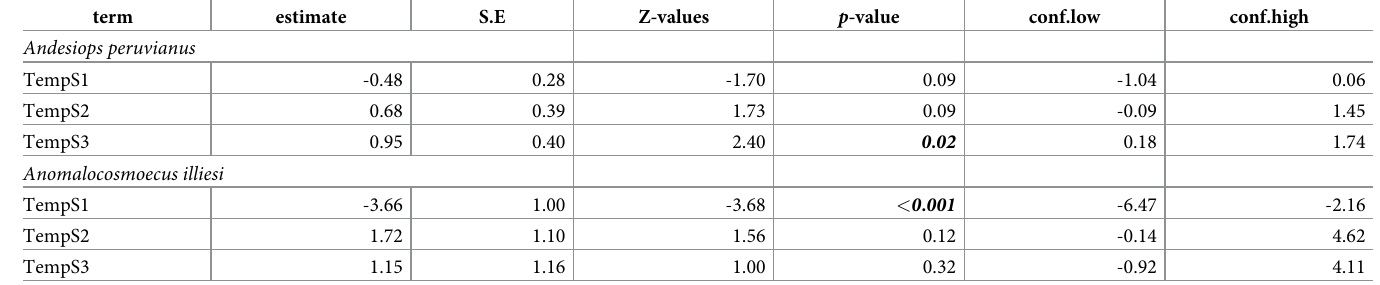
Table 2. Coefficients from the GLM (family = quasibinomial) of mortality rates for Andesiops peruvianus and Anomalocosmoecus illiesi in different temperature scenarios. Estimates were in link = logit with confident high (conf.high) and low (conf.low) values. Temp: S1 (control) S2 (+2.5˚C) and S3 (+5˚C). Significance coefficients (C I = 95%) are in bold.